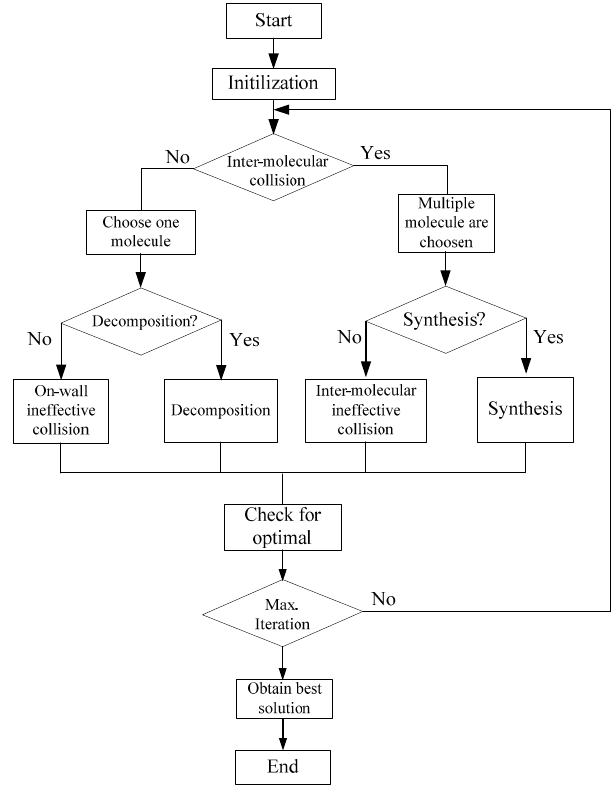
Figure 5. Schematic diagram that illustrates the CRO optimization framework.